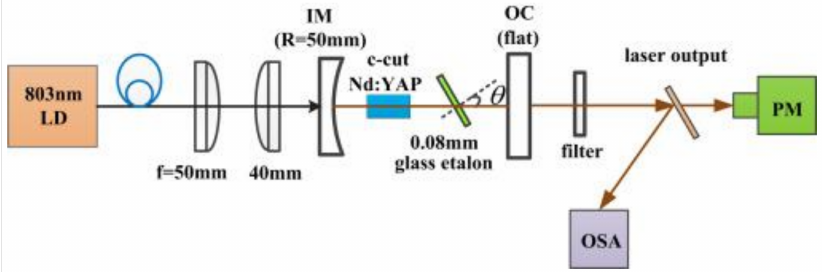
Figure 7. Set-up used for the LD-pumped Nd:YAP continuous-wave laser experiments. OSA, optical spectrum analyzer; PM, power meter; OC, output coupler